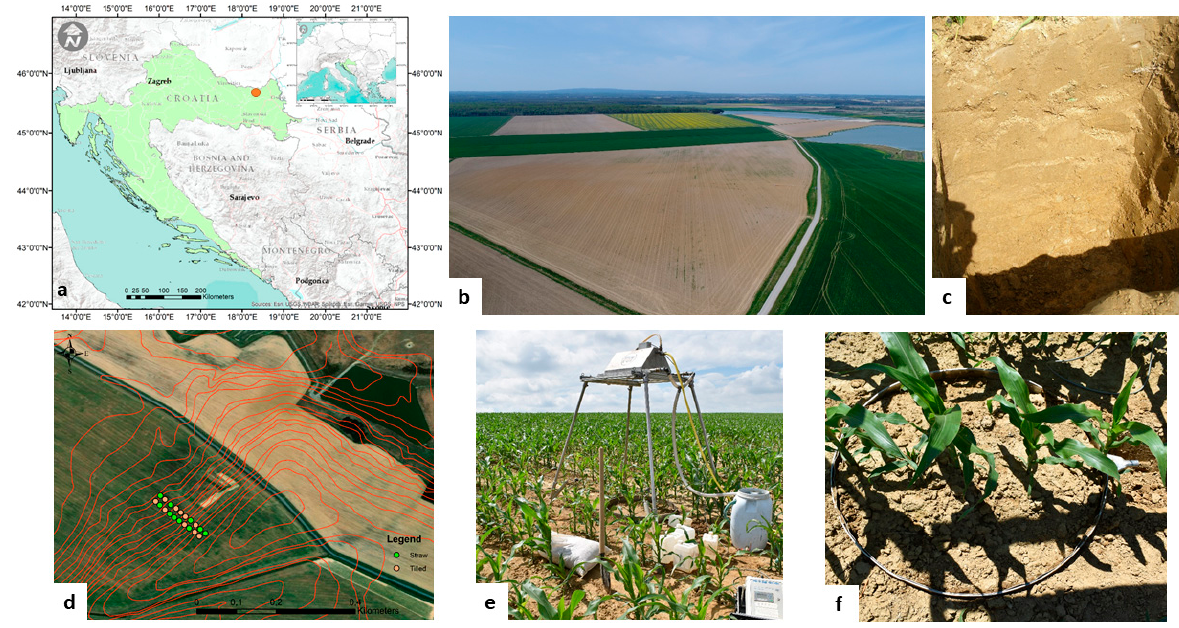
Figure 1. ( a ) Study site Location, ( b ) view of the study site, ( c ) soil profile, ( d ) sampling strategy, ( e ) rainfall simulator during installation, and ( f ) view of the plot size and shape.